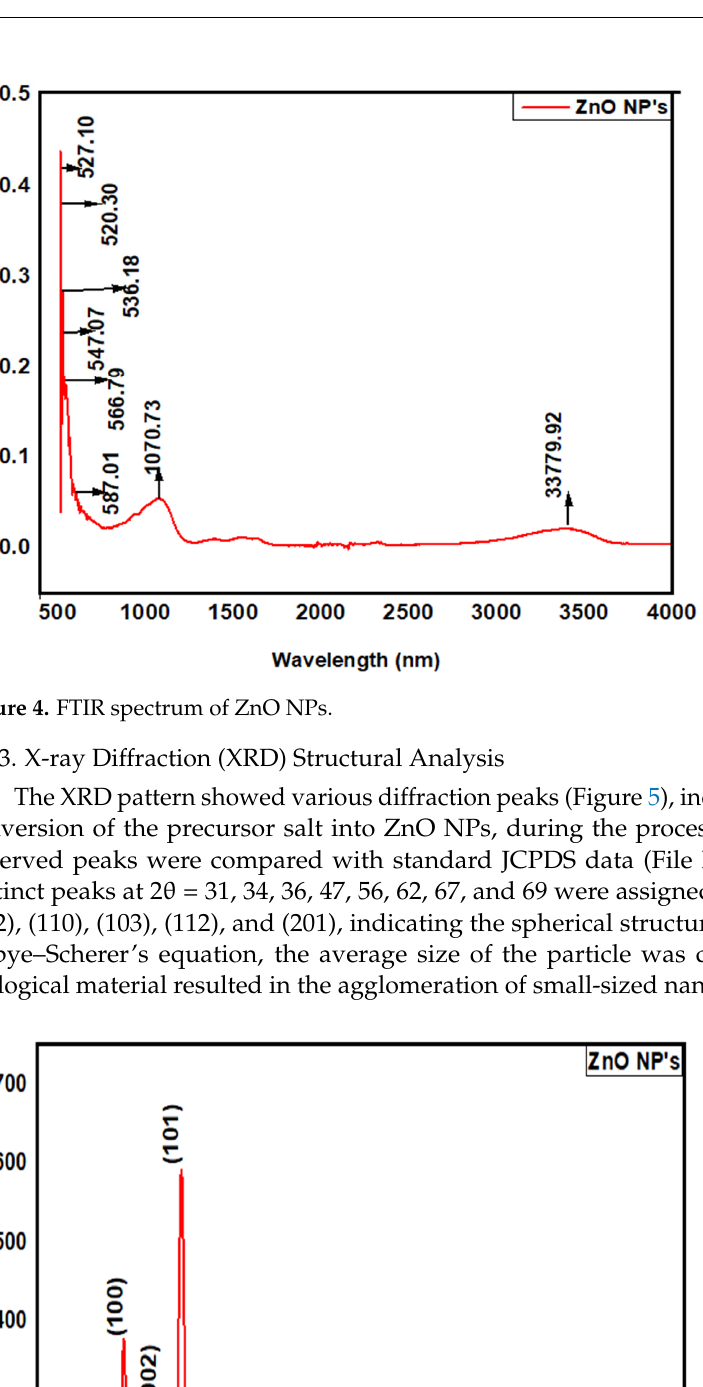
8 of 21 Figure 3. UV–visible spectrum of ZnO NPs. 3.2.2. Fourier Transform Infrared (FTIR) Spectroscopy FTIR analyses were used for the determination of possible active biomolecules (Fig ‐ ure 4). These biomolecules are accountable for the reduction of Zn ions and capping of ZnO NPs. Obtained FTIR spectra showed absorption peaks at 3379.9 cm − 1 , indicating the